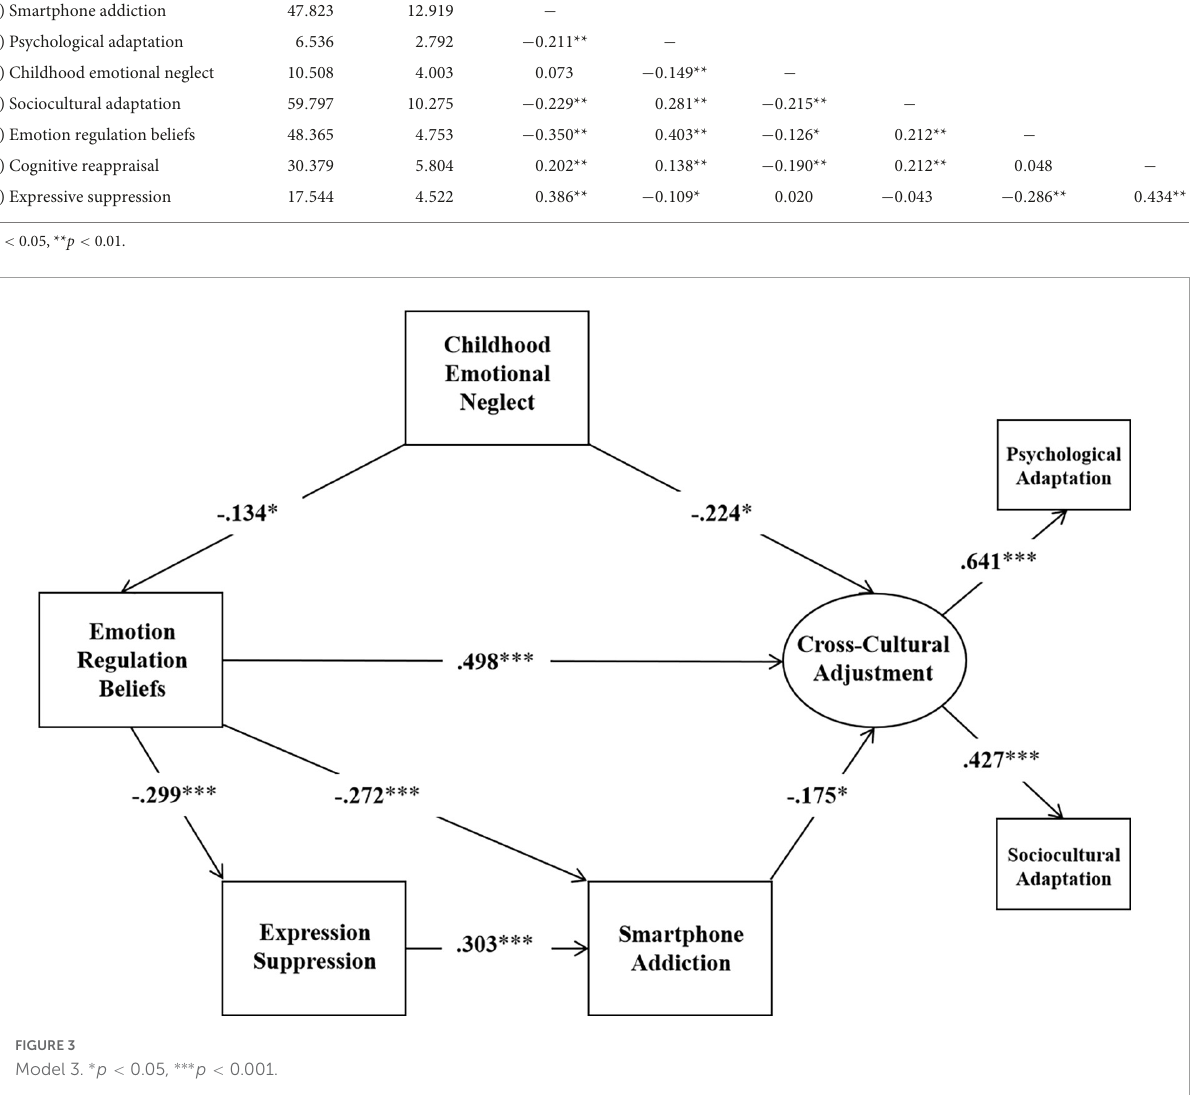
cross-cultural adjustment through smartphone addiction, with a mediated effect size of 0.048 ( p > 0.05, 95% confidence interval [0.006,0.114]); there was a significant indirect effect of childhood emotion neglect on cross-cultural adjustment through emotion regulation beliefs, with a mediated effect the amount of mediated effect was − 0.067 ( p < 0.05, 95% confidence interval [ − 0.136, − 0.014]); emotion regulation beliefs have no significant indirect effect on cross-cultural adjustment, through the expression suppression as well as the role of smartphone addiction, the mediated effect size was 0.016 ( p > 0.05, 95% confidence interval [0.003, 0.037]); emotion regulation beliefs had a significant indirect effect on smartphone addiction through expression suppression, with a